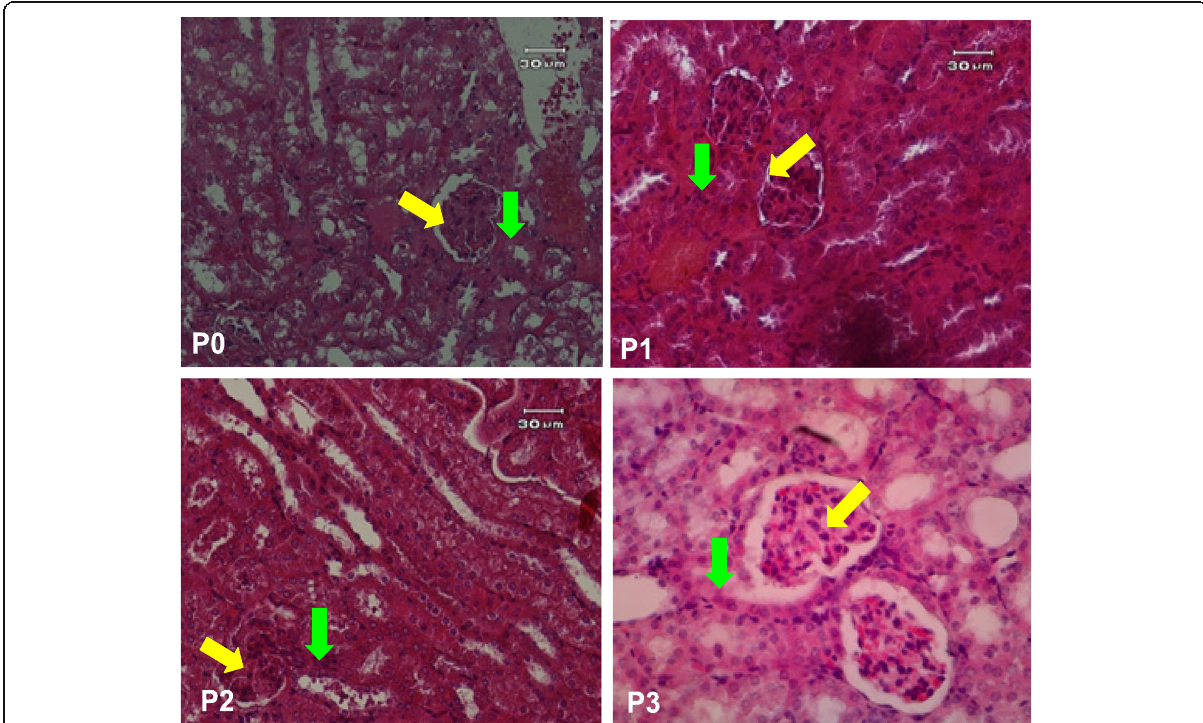
Fig. 3 Renal histology in the rats given the ethyl acetate fraction of the Malaka flesh. Yellow arrow = Glomerulus, green arrow = proximal